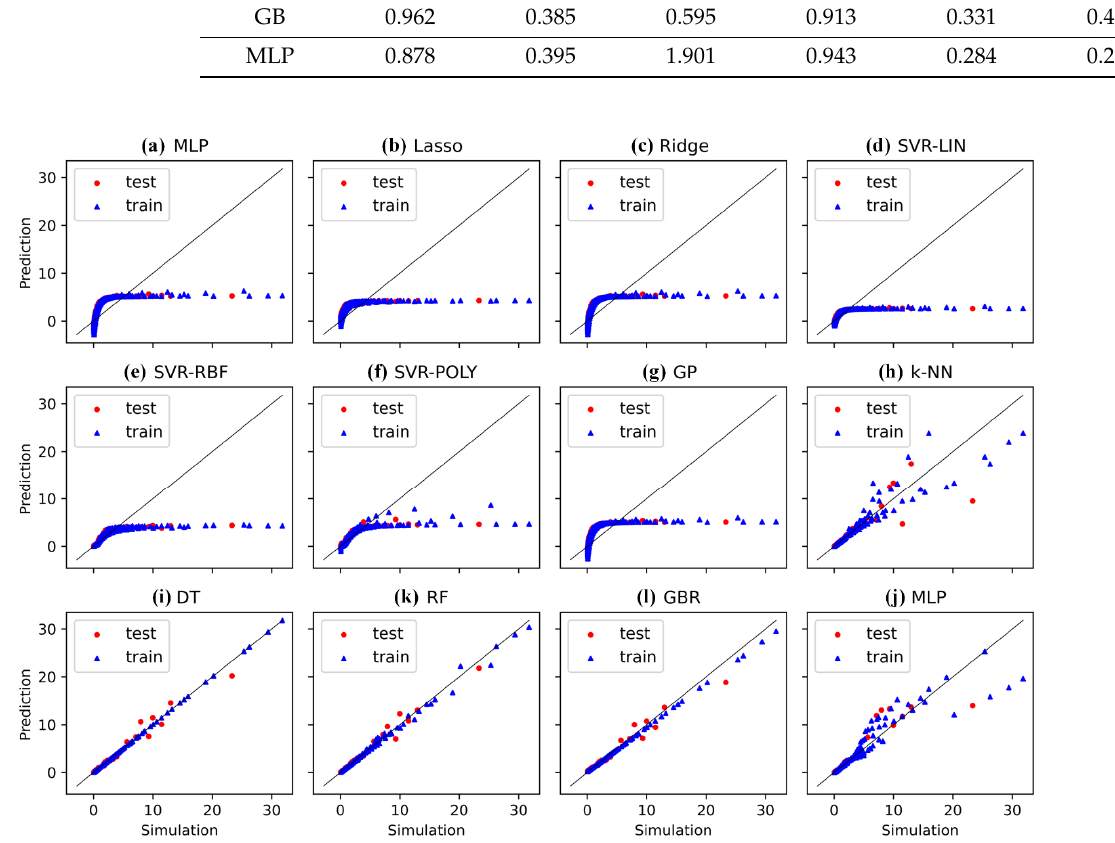
Figure 5. Simulation versus predicted values for bulk diffusion of the LJ fluid, being the output of 12 different algorithms ( a – l ). Data points include both training and test data. The 45 ◦ identity line denotes the perfect match.